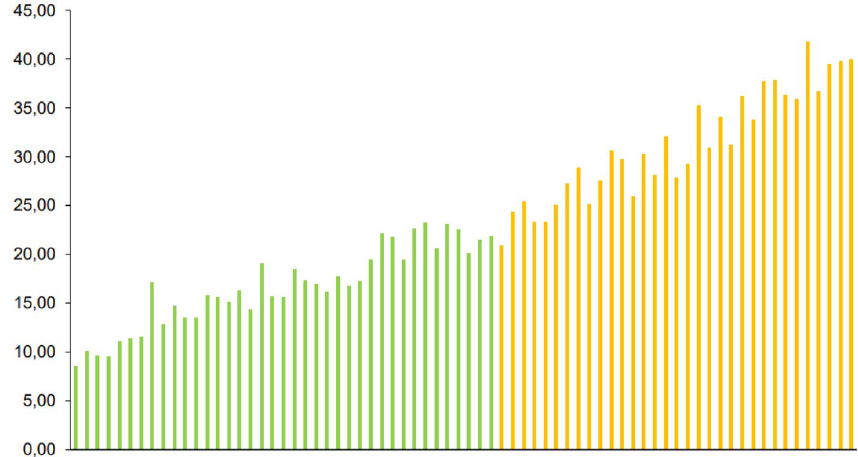
Figure 3. Distribution of 72 ½ Angus × ½ Nellore heifers based on horn fly counts. Green, yellow means resistant and resilient animals, respectively.